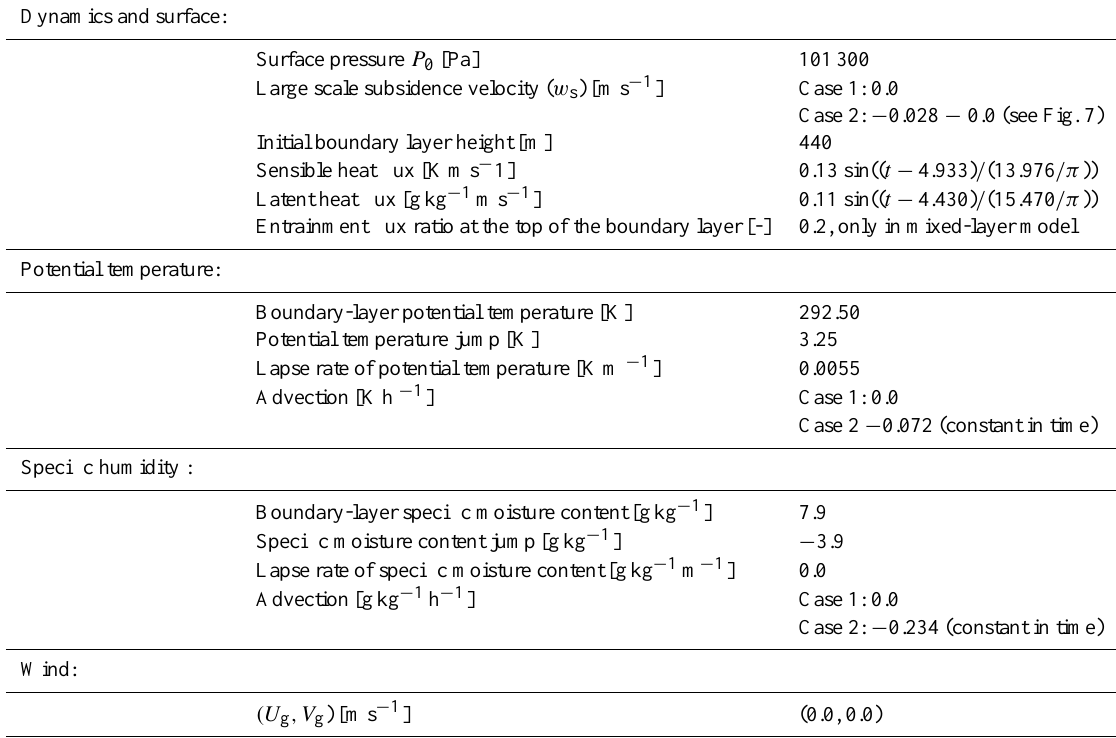
Table 1. Prescribed initial conditions for the numerical experiments using mixed-layer theory and DALES. The conditions correspond at 10:00UTC at 25 June 2011 at Campistrous (France). t is the time after starting the simulation. Dynamics and